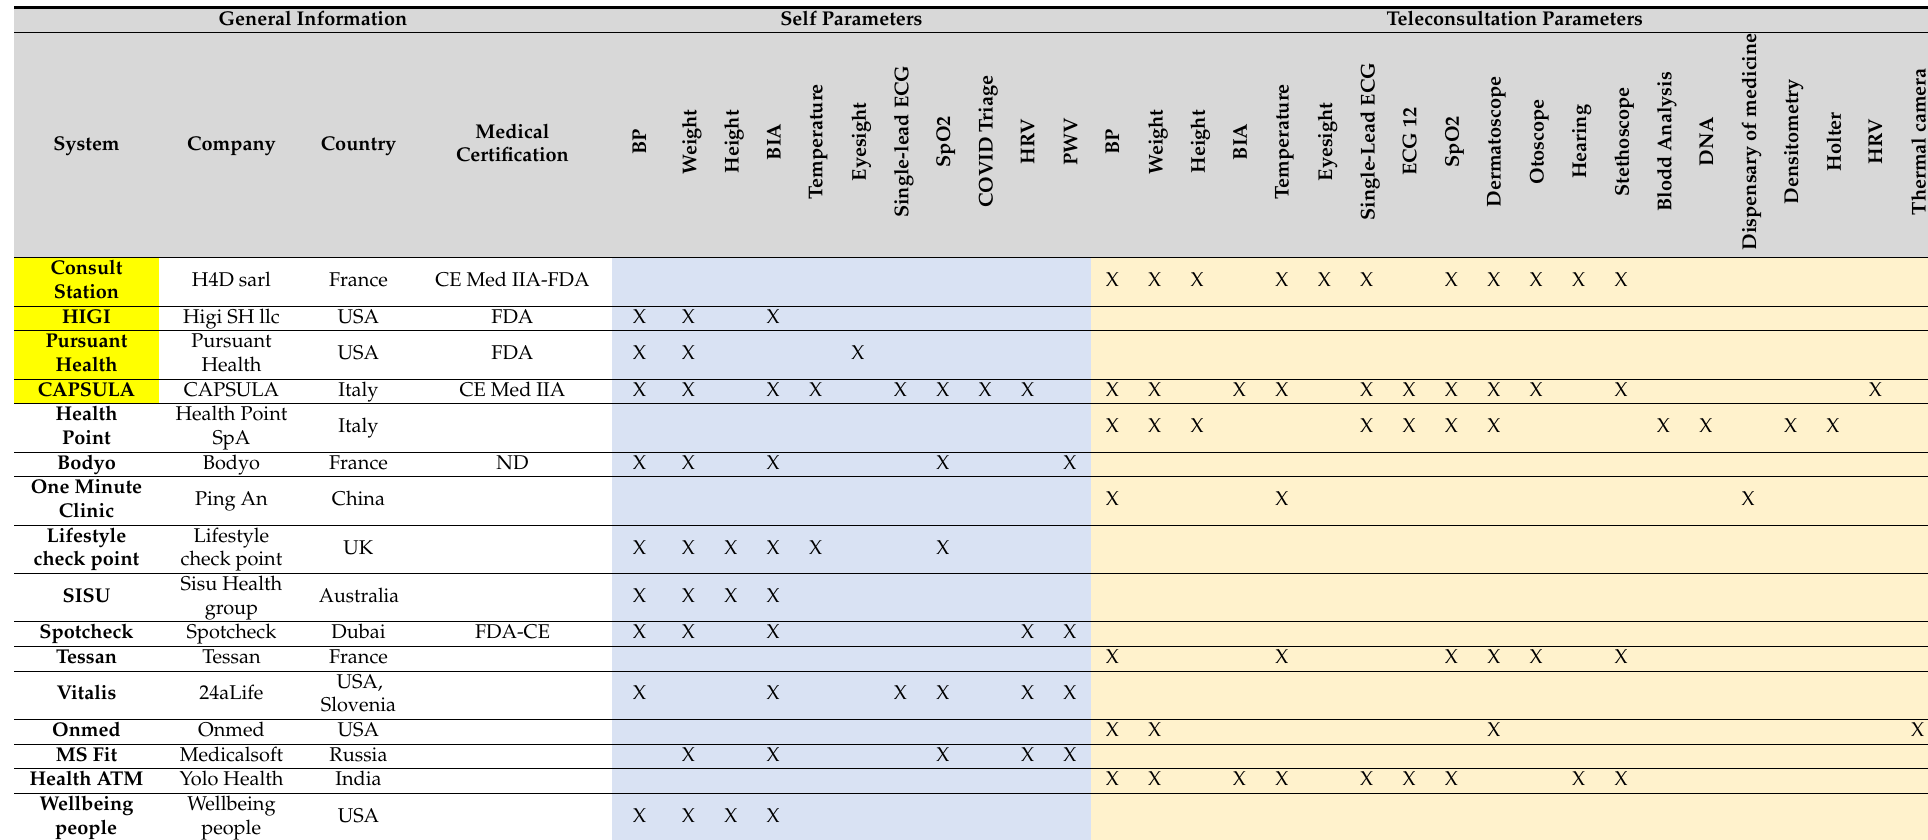
Table 1. Analysis of competitors in health pods. In yellow the most interesting initiatives adopting a self-assessment approach are